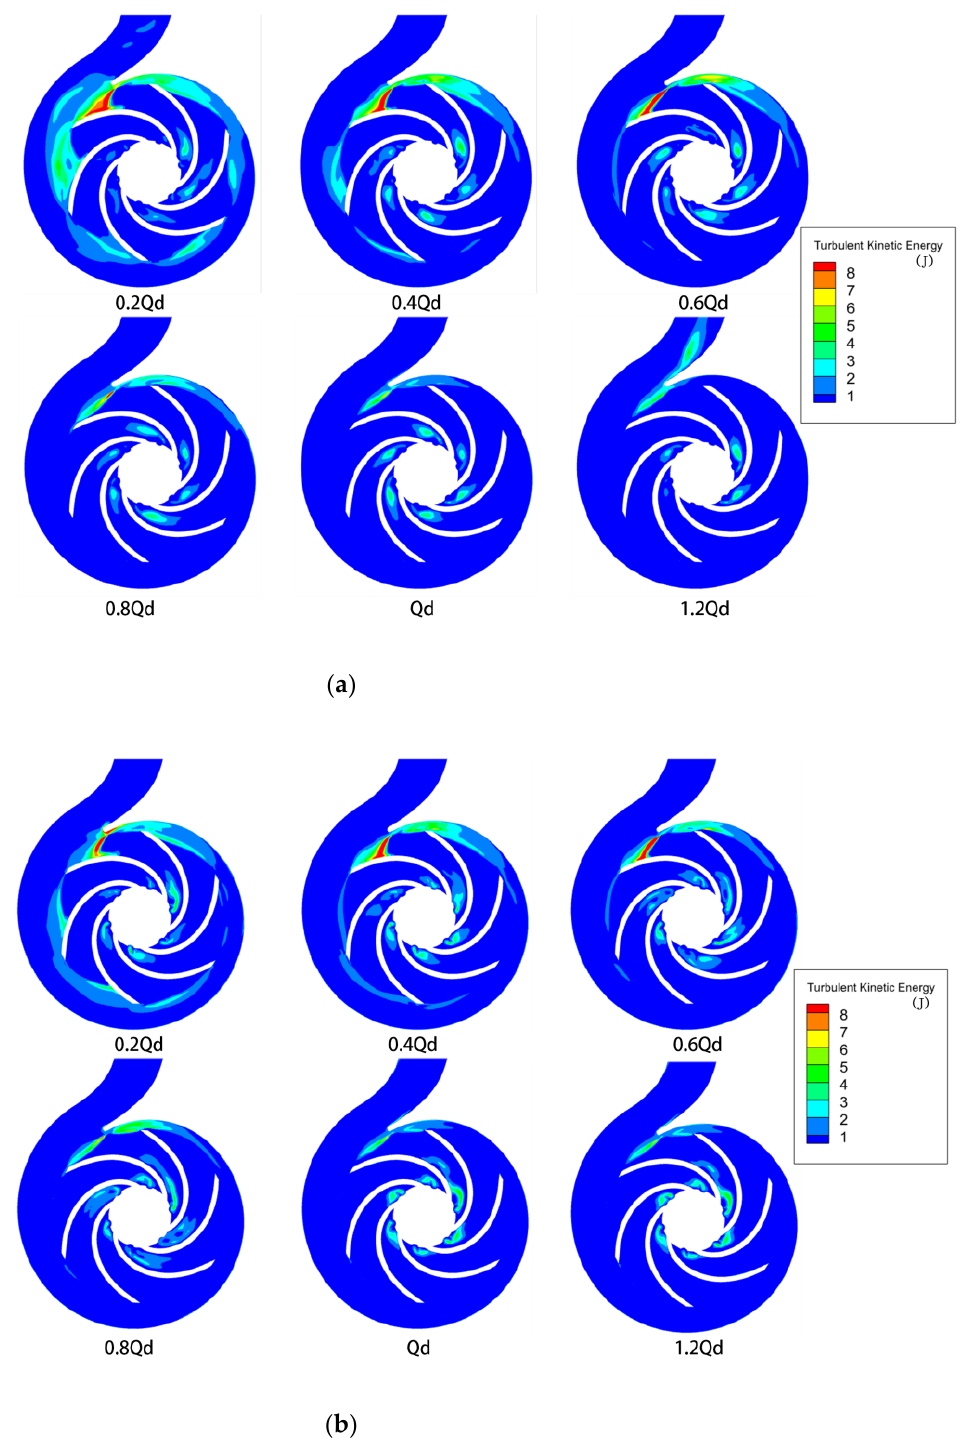
Figure 13. Turbulent kinetic energy contours in the centrifugal pump. ( a ) Cases with water; ( b ) cases with drilling fluid.